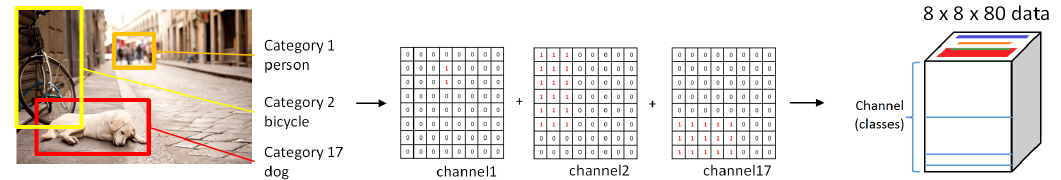
Figure 3. Input data structure and encoding process of the proposed method. Annotated images are used for providing labels and location information. The number of the channel of the input data structure is the total number of categories from the